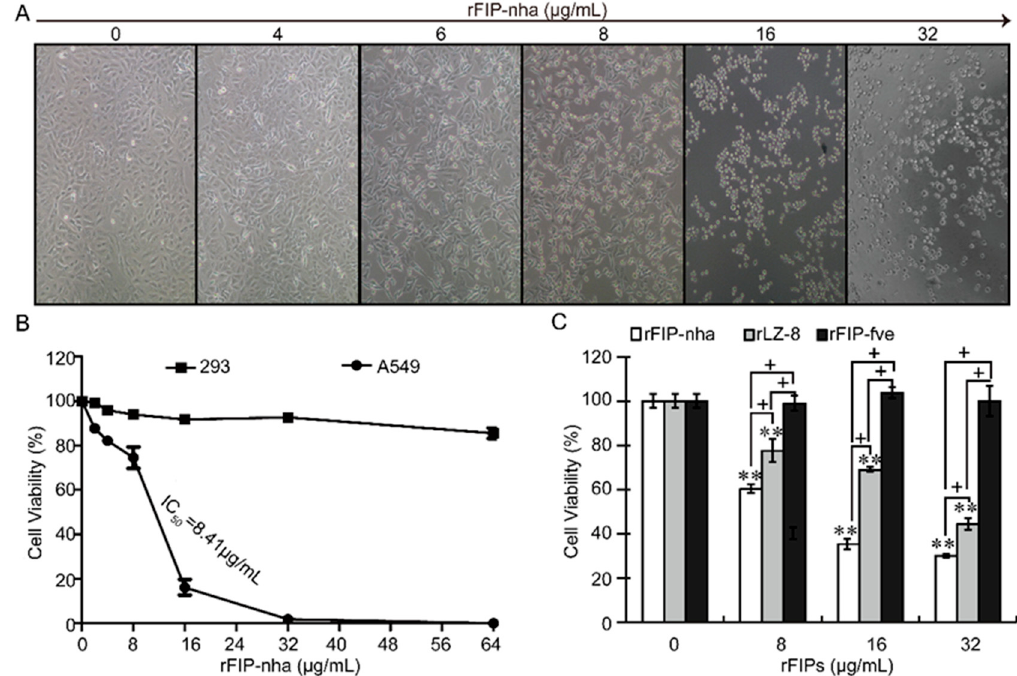
Figure 1. Cytotoxicity assay of recombinant fungal immunomodulatory protein from Nectria haematococca (rFIP-nha) in A549 cells. ( A ) Morphological observation of A549 cells after rFIP-nha treatment. A549 cells were treated with 0, 4, 6, 8, 16, or 32 µ g / mL rFIP-nha for 24 h, and micrographs were collected on a Zeiss microscope at 200 × magnification. ( B ) Cell viability assay. A549 cells and normal HEK293 cells were treated with varying concentrations (0, 2, 4, 8, 16, 32, or 64 µ g / mL) of rFIP-nha for 24 h, followed by CCK assays. ( C ) Comparison of cytotoxicity between rFIPs. A549 cells were treated with varying concentrations (0, 8, 16, or 32 µ g / mL) of rFIP-nha, rLZ-8, or rFIP-fve for 24 h, followed by CCK assays to estimate cell viability. Each bar represents mean ± SD ( n = 3). **: p < 0.01 compared to control (0 µ g / mL). + : p < 0.05 between di ff erent FIPs at the same concentration.